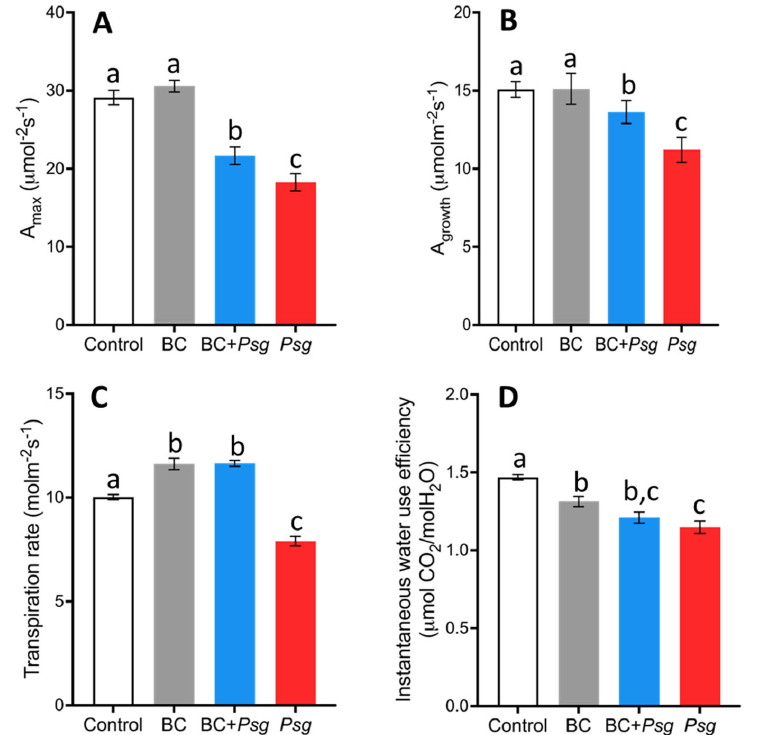
Figure 5. ( A − D ) . Variations in mean photosaturated photosynthetic rate A max ( A ),